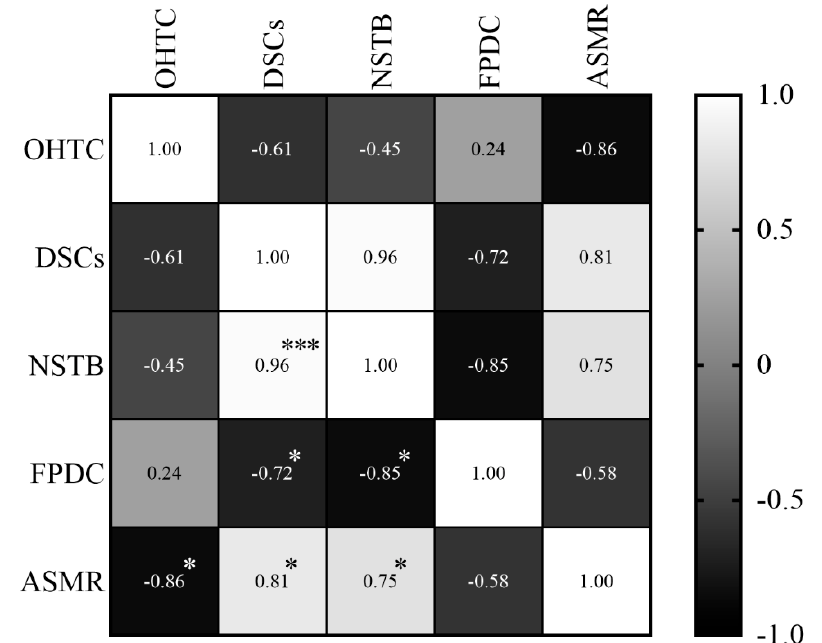
Figure 9. Correlations between the specific mortality rate in individuals and variables of primary and specialized care, between 2011 and 2018. The shade gradient bar shows correlation coefficient. The asterisk indicates p -values < 0.05 * and <0.0001 ***. Age-standardized mortality rate (ASMR), oral health teams coverage (OHTC), first programmatic dental consultations (FPDC), dental specialty centers (DSCs), and number of soft tissue biopsies (NSTB).